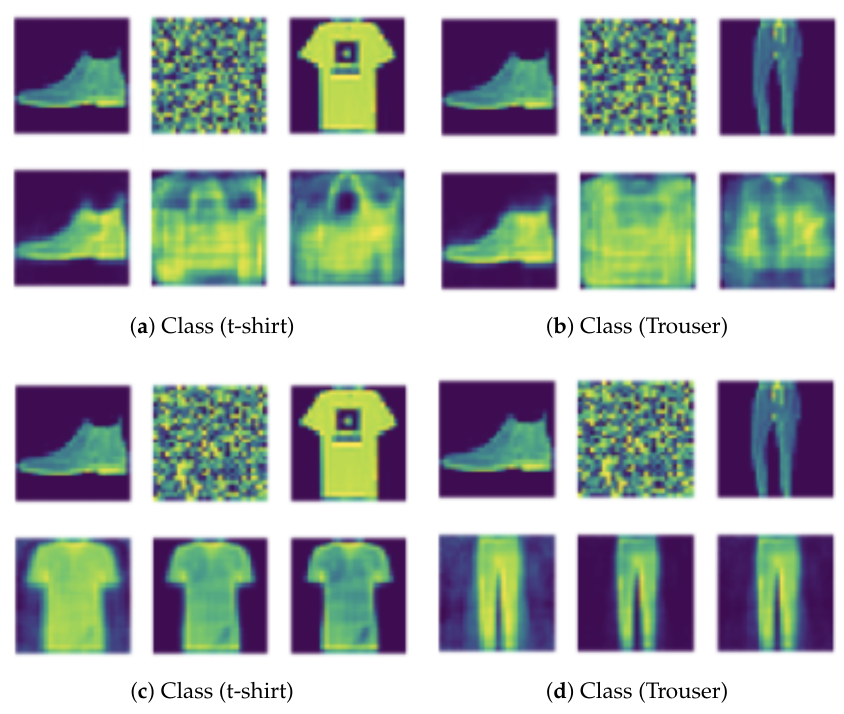
Figure 3. An ablation study ( Top ) and an insertion study ( Bottom ) with different examples and different identification of class pathway on the fashion MNIST